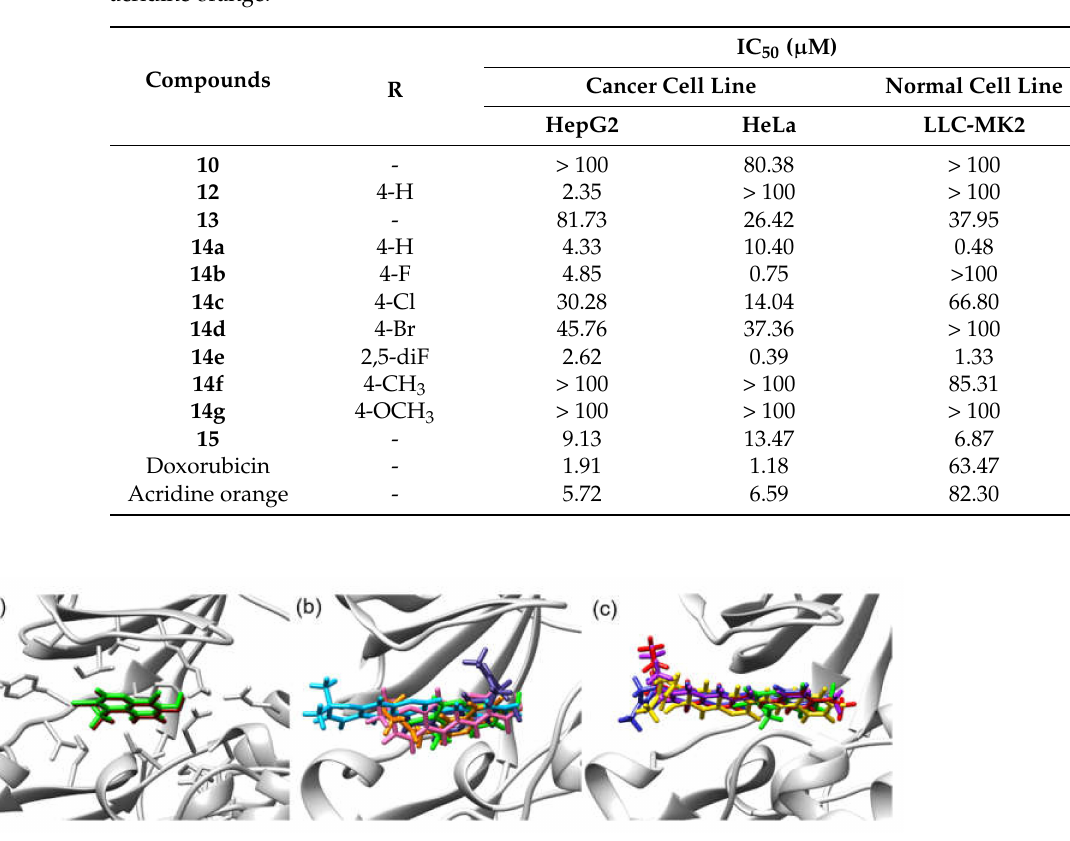
Table 2. In vitro anticancer activities of synthesized coumarins compared with doxorubicin and